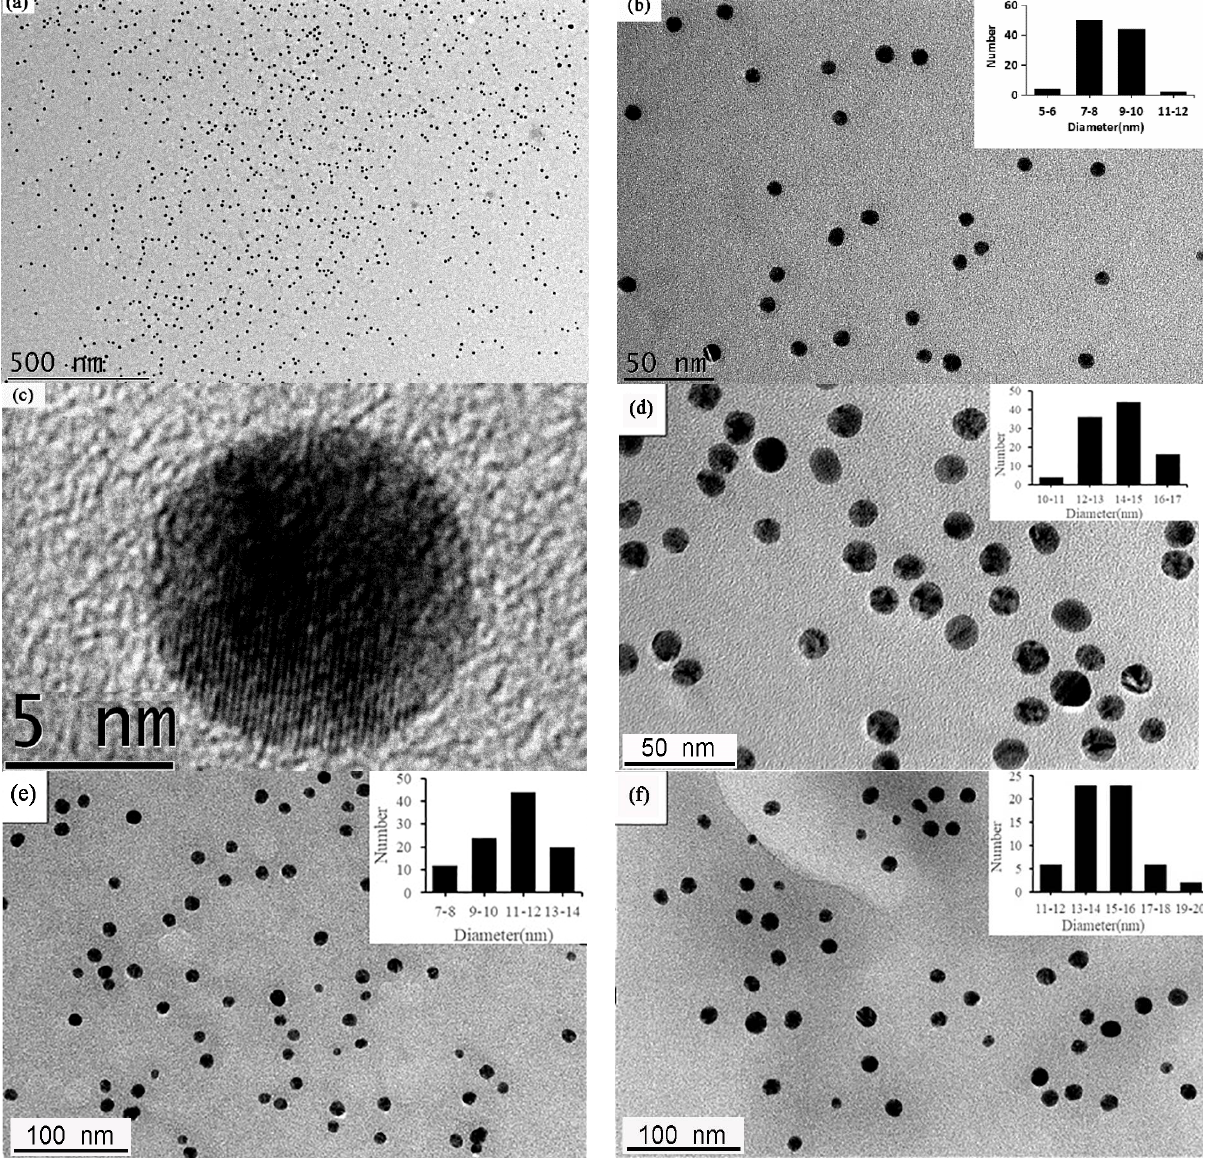
Figure 2. ( a ) Low-magnification TEM image of the functionalized chestnut-shell-extract AgNPs. ( b ) An enlarged TEM image of the Ag nanoparticles. ( c ) High-resolution TEM image of one Ag nanoparticle. ( d ) The representative TEM image of the Ag nanoparticles produced by seed-growth method. ( e ) The TEM image of the synthesized AgNPs at pH 7.0. ( f ) The TEM image of the synthesized AgNPs using 0.8 mL 5% AgNO 3